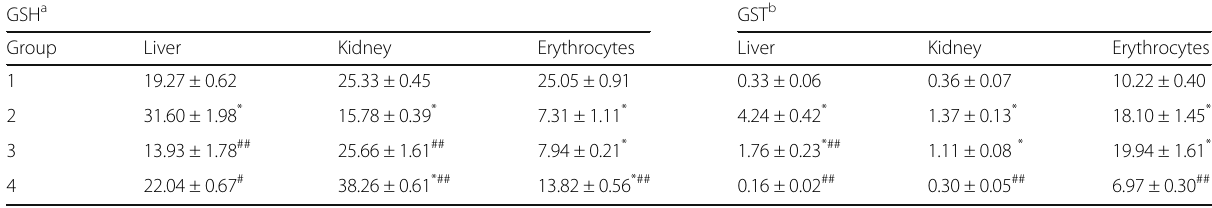
Table 7 Effect of HIE on GSH and GST and in STZ induced diabetic mice GSH a GST b